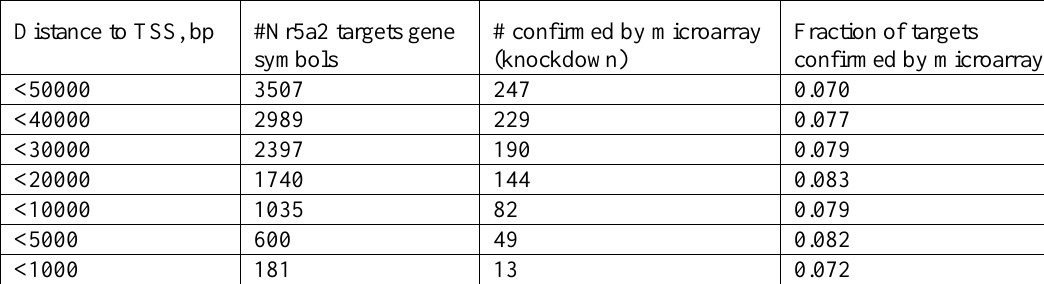
Table 1: Number of genes-Nr5a2 targets depending on distance to